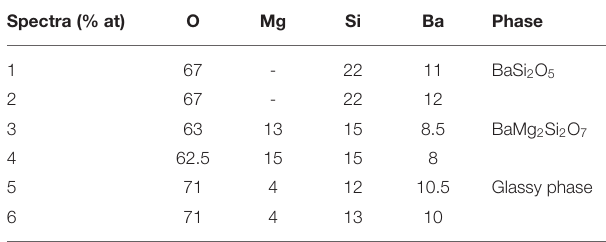
TABLE 4 | Elemental analysis corresponding to Figure 4 . Spectra (%